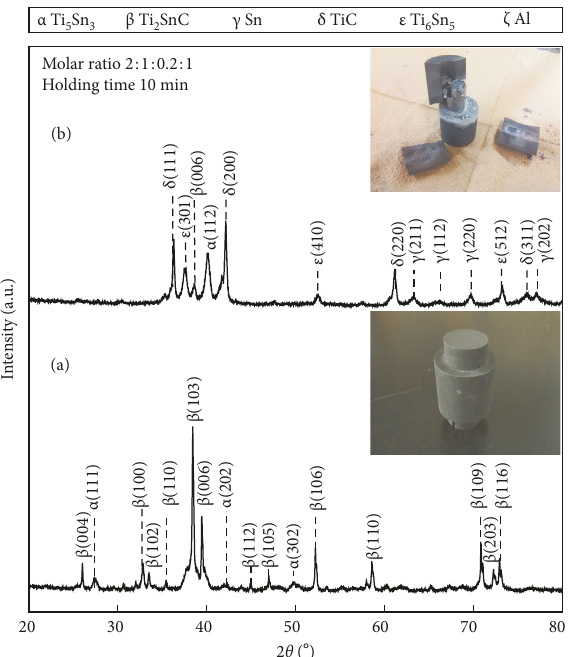
Figure 5: XRD pattern and SEM of the sample with molar ratio 2:1:0.2:1 at 1400 ° C sintering temperature on pressure of (a) 0 and